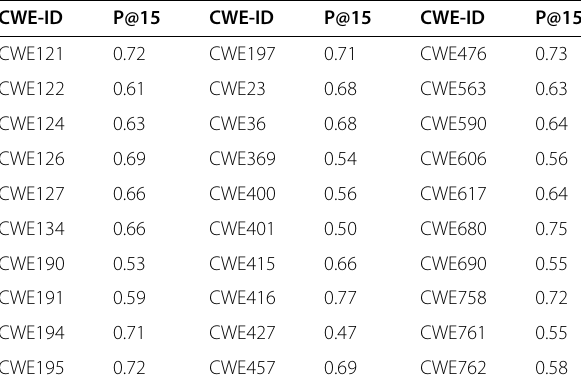
Table 4 Asm2vec Precision@15 on Juliet Test